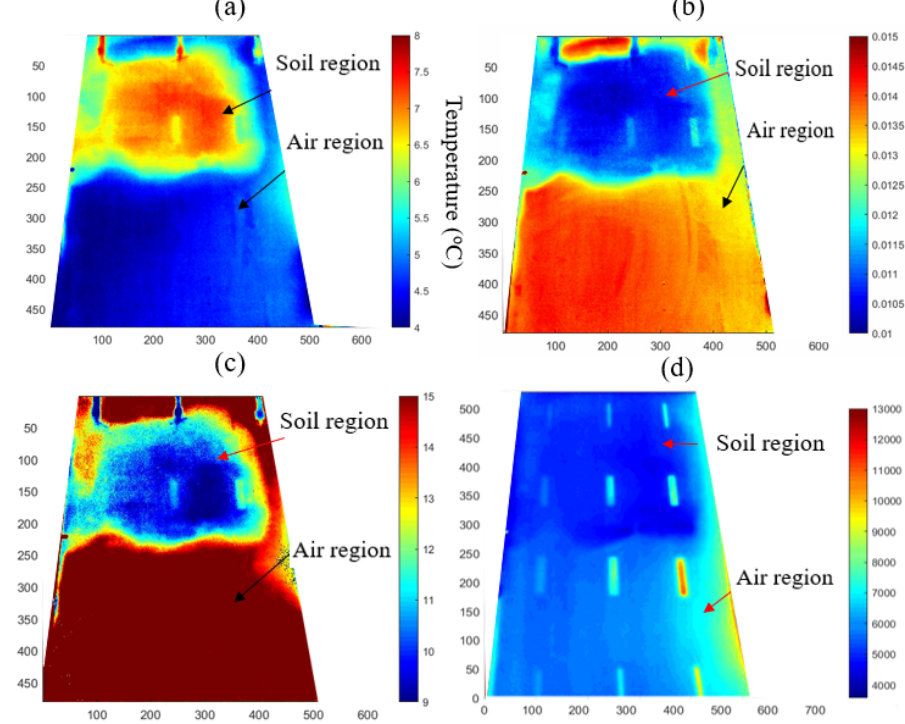
Figure 9. Results of analysis of thermal image sequences. ( a ) single frame of the raw thermal image, ( b ) cooling constant map of Newton’s cooling law analysis, ( c ) result of peak logarithmic second derivative method, ( d ) result of frame subtraction method.